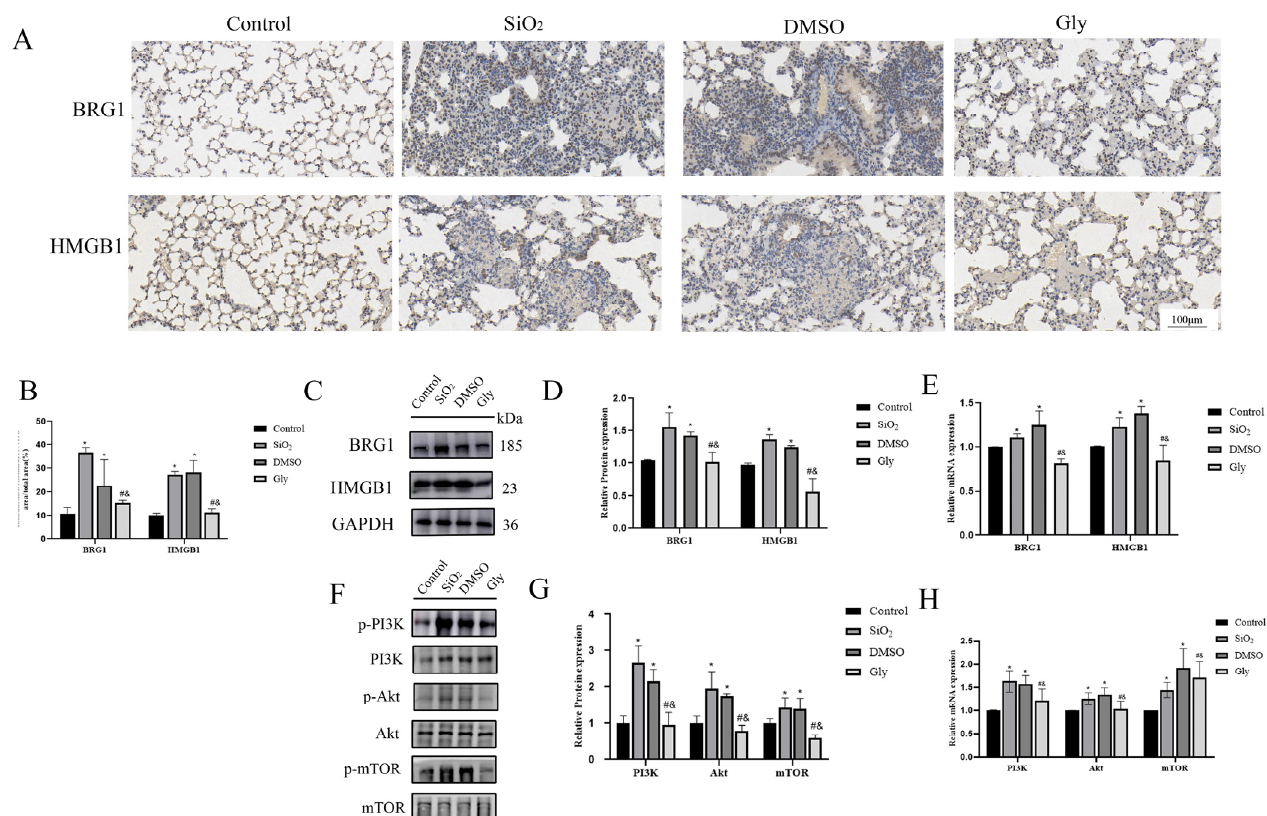
Figure 8. Glycyrrhizic acid inhibits the expression of HMGB1 and BRG1 through PI3K/Akt/mTOR pathway. ( A ) IHC staining showing HMGB1 and BRG1 expression in these four groups respectively. × 200. Scale bar = 100 µ m. Blue indicates the location of the nucleus and brown indicates the expression of specific proteins. ( B ) Quantification. ( C , E ) The expression of HMGB1, BRG1, and GAPDH were detected by Western blotting and RT-qPCR. ( D ) Quantification. ( F , H ) PI3K, p-PI3K, Akt, p-Akt, mTOR, and p-mTOR expression in mouse lung tissue were detected by Western blotting and RT-qPCR. ( G ) Quantification. Shown are the averages of three independent experiments. GAPDH was used as an internal control *: p < 0.05 compared with the control group; #: p < 0.05, compared with the SiO 2 group; &: p < 0.05, compared with the solvent control